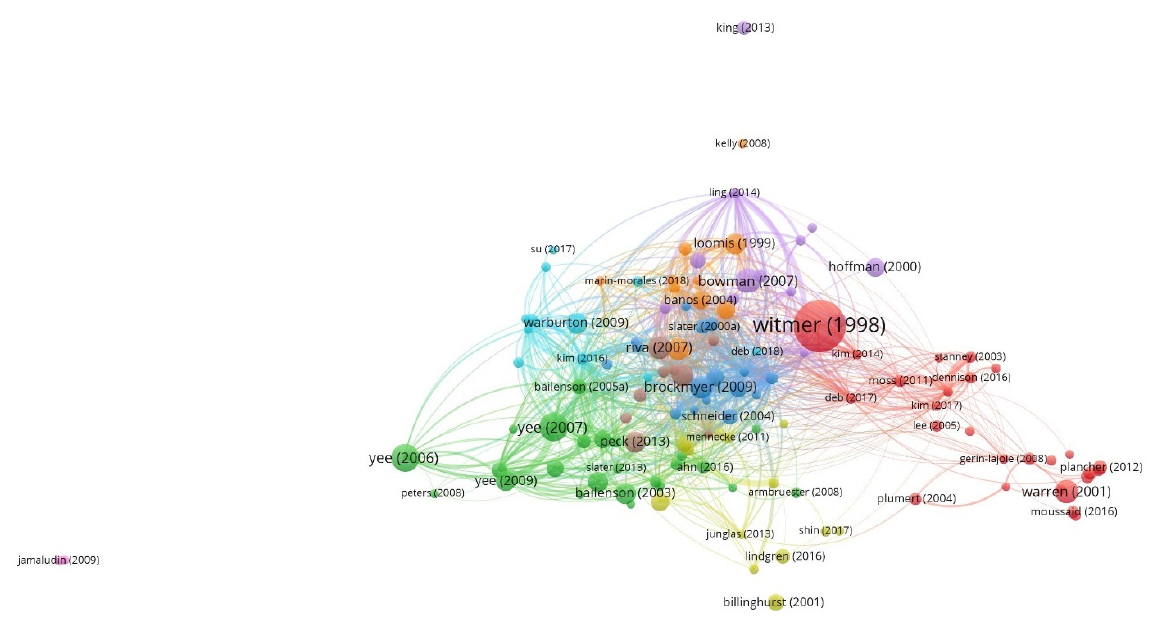
Figure 12. Bibliographic coupling analysis map showing development of literature themes and seminal publications in clusters. Table 10. Top 12 seminal publications and thematic clusters through bibliographic coupling analysis of citing references.